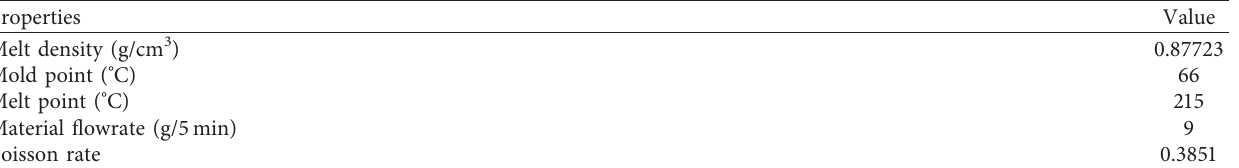
Table 2: Assets of